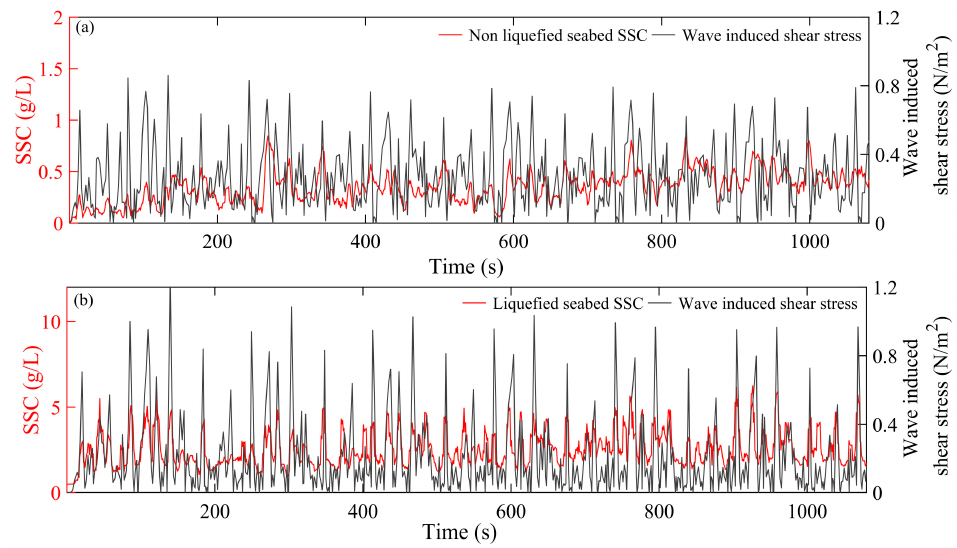
Figure 10. Relationship between SSC (at 5 cm above the seabed) and wave-induced shear stress in the ( a ) non-liquefied and ( b ) liquefied states; the red curve is SSC and the black curve is wave-induced shear stress, τ w